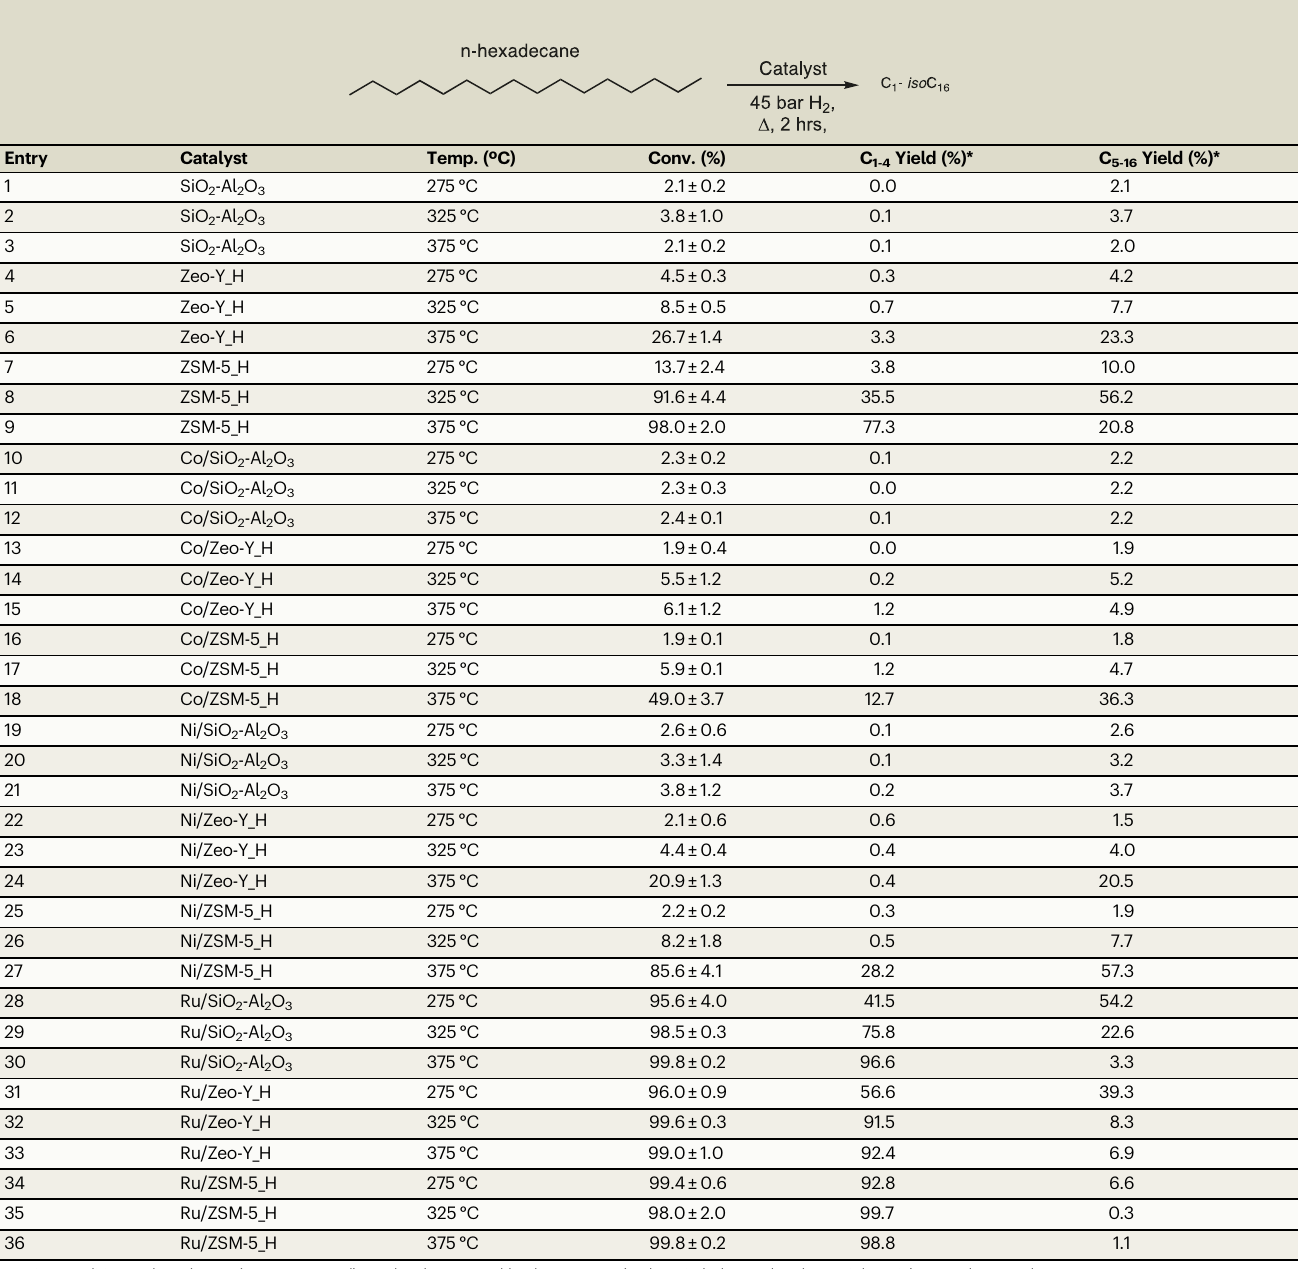
Table 2 | n- Hexadecane deconstructions with the 12 catalysts from the main library at 275, 325, and 375 °C